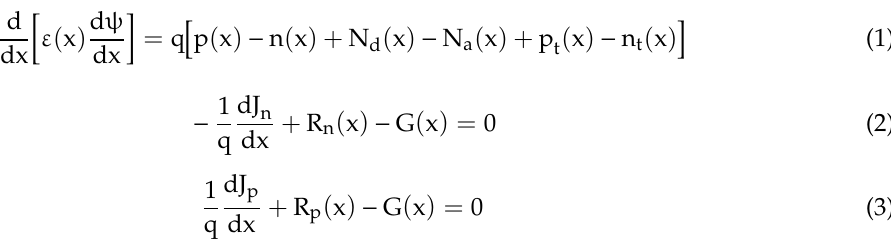
Figure 3. Effect of different ETL materials on QE. Figure 4. Band alignment between ETL materials and MASnI 3 perovskite.